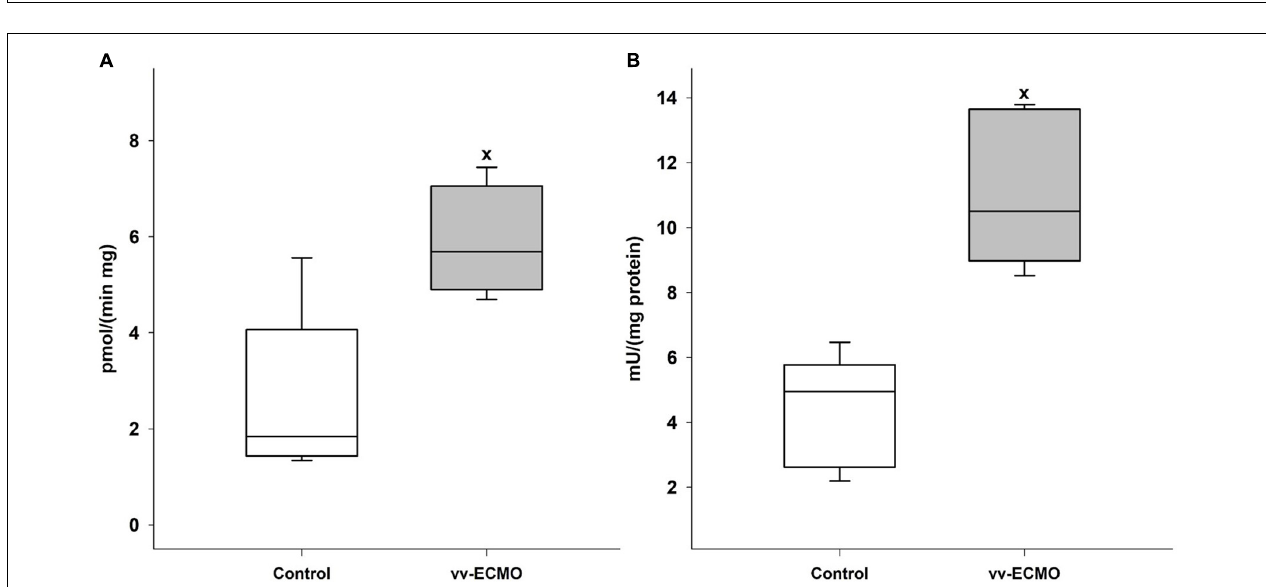
FIGURE 6 | Changes in the xanthine-oxidoreductase (A) and myeloperoxidase (B) enzyme activities in the renal tissue in the control group (empty box) and vv-ECMO group (gray box). The plots demonstrate the median (horizontal line in the box), the 25th and 75th percentiles, and the range of data (whiskers). x P < 0.05 for the vv-ECMO vs. control group values (Mann–Whitney